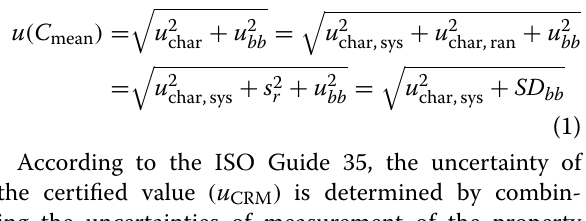
Table 4 Uncertainty sources in the ID–LC/MS method for the determination of biotin in multivitamins